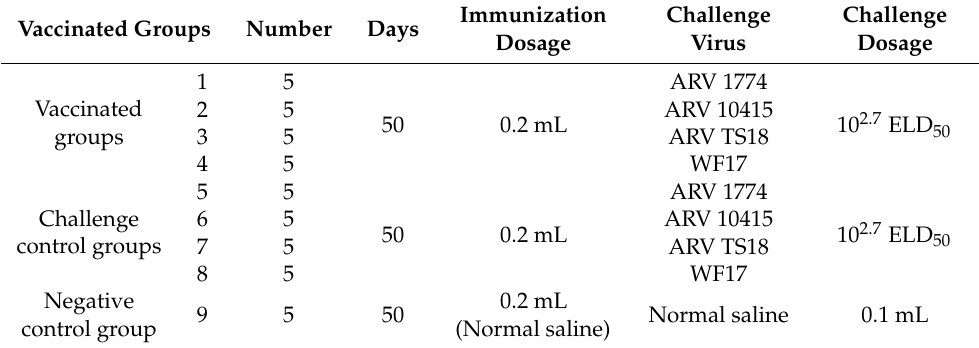
Table 1. Methods of the challenge